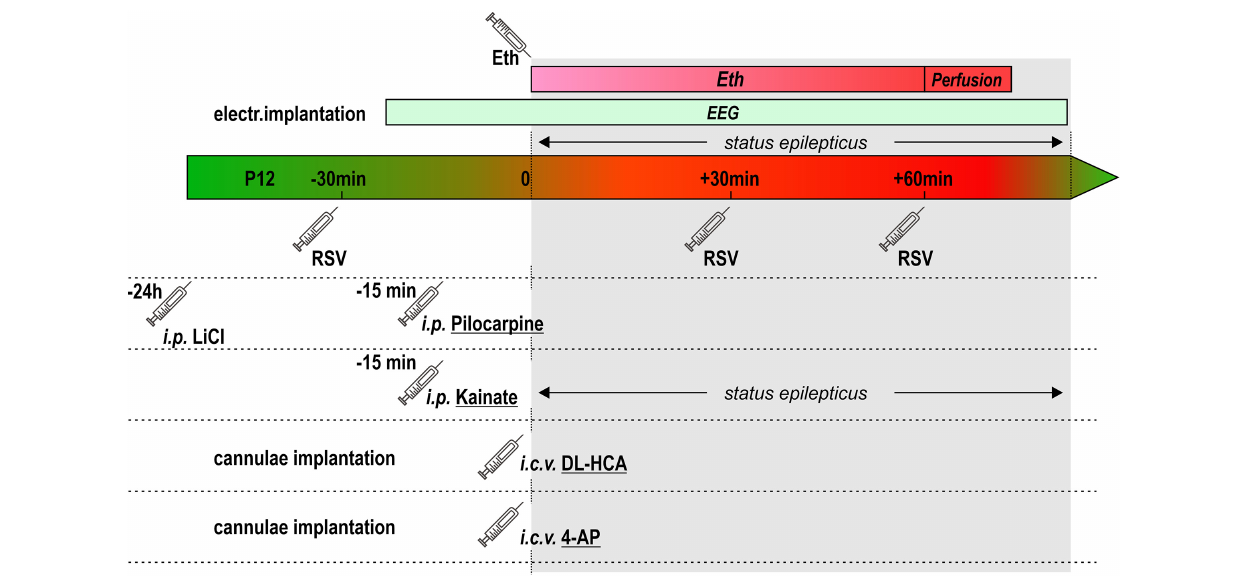
FIGURE 1 | Schema of experimental